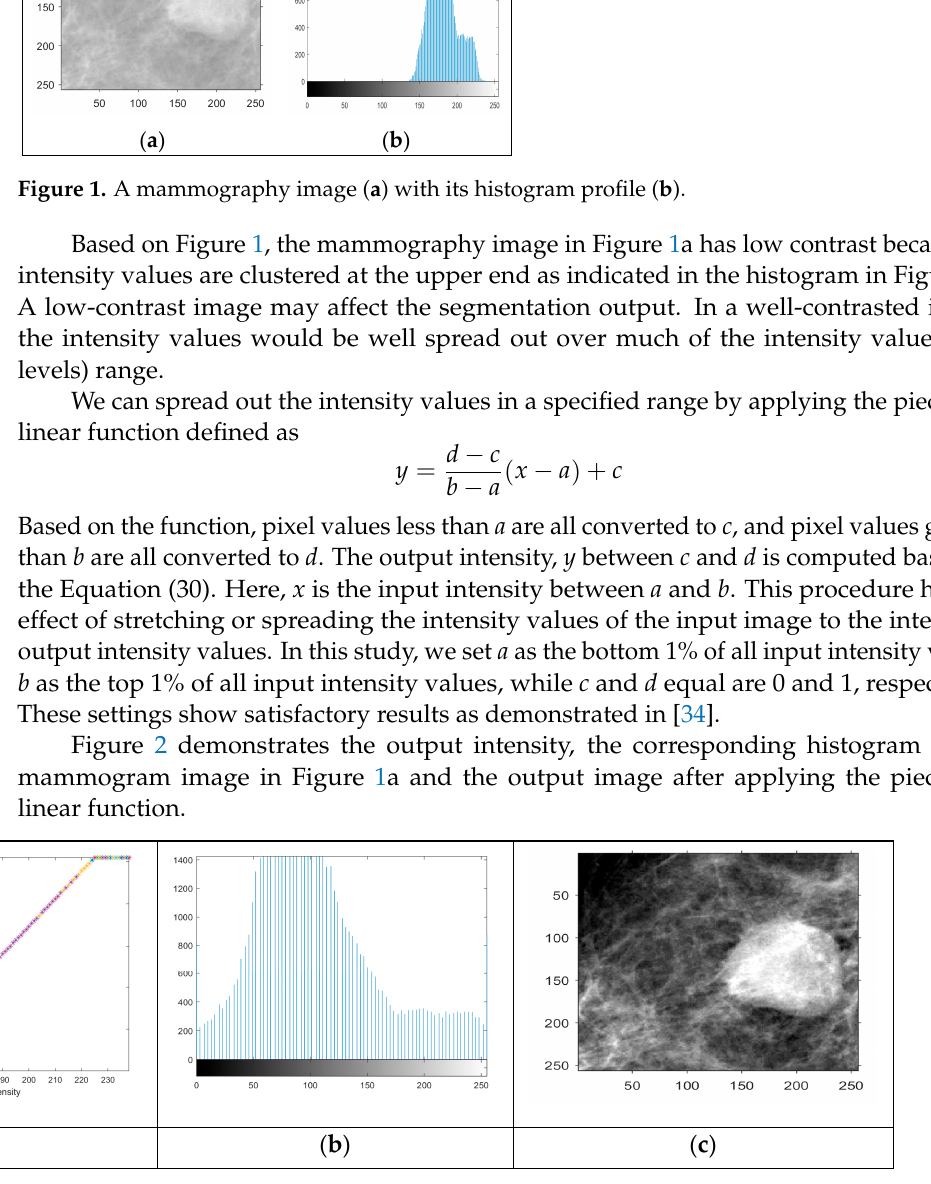
Figure 2. The output intensity ( a ), the corresponding histogram ( b ) and the output image ( c